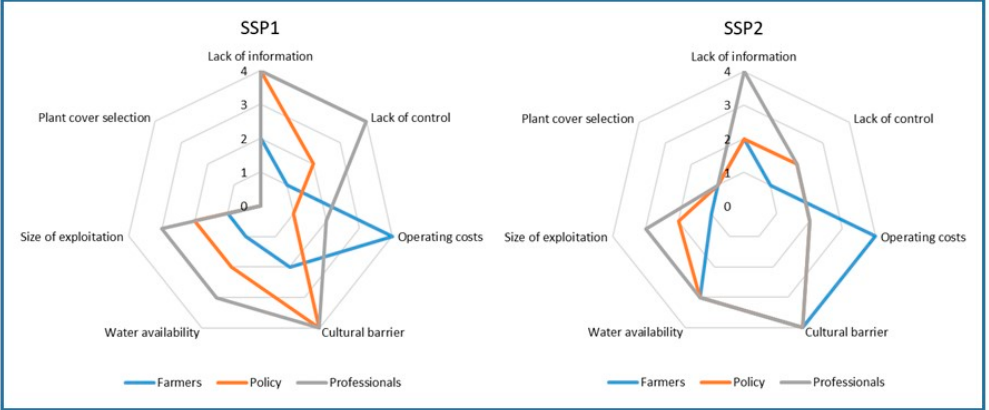
Figure 4. Main barriers assessed during the second process of interviews of SSPs.